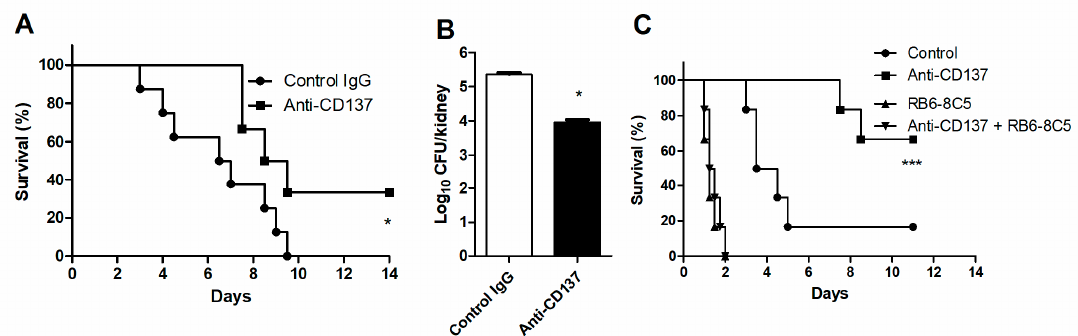
Figure 5. Neutrophils are required for anti-CD137-mediated enhancement of fungal clearance. ( A , B ) Neutrophils were isolated from WT mice and adoptively transferred to Tnfrsf9 − / − mice (5 × 10 6 cells per mouse) immediately before injection with control or anti-CD137 antibody. Six hours later, mice were infected with 3 × 10 5 CFU C. albicans . ( A ) Survival rates ( n = 5 mice per group). ( B ) Fungal burdens in 3-d post-infection kidneys. ( n = 5 mice per group). ( C ) Survival rates of mice depleted of neutrophils ( n = 6 per group). Fungal burden in kidneys ( n = 5 mice per group). Results are representative of 3 experiments. * p < 0.05; *** p < 0.001 between the two groups or between the indicated group and the other 3 groups.